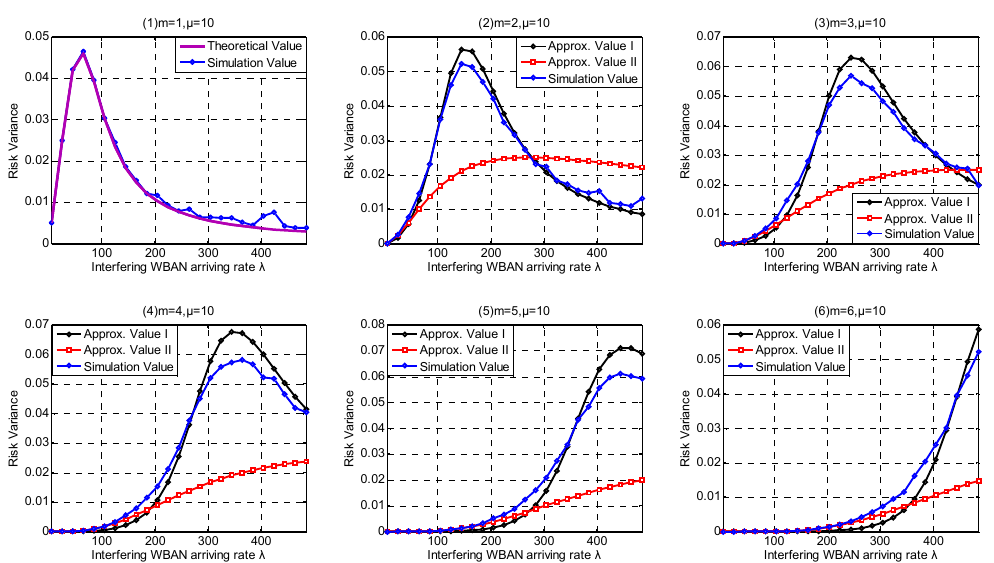
Figure 18. Risk Variance in Service-independent coexisting WBANs.